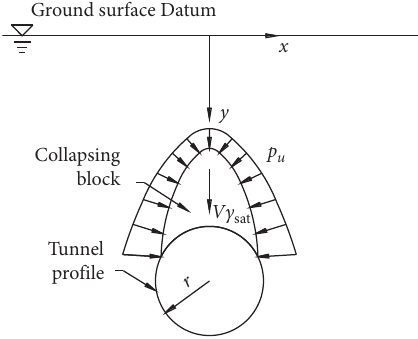
Figure 3: Diagram of external force on collapsing